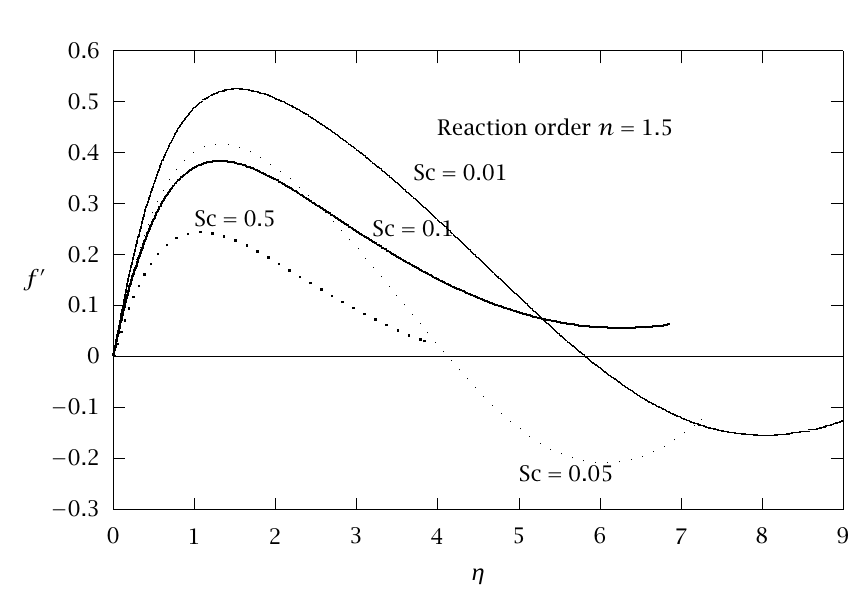
Figure 5.9 . Velocity profiles for n = 1 .